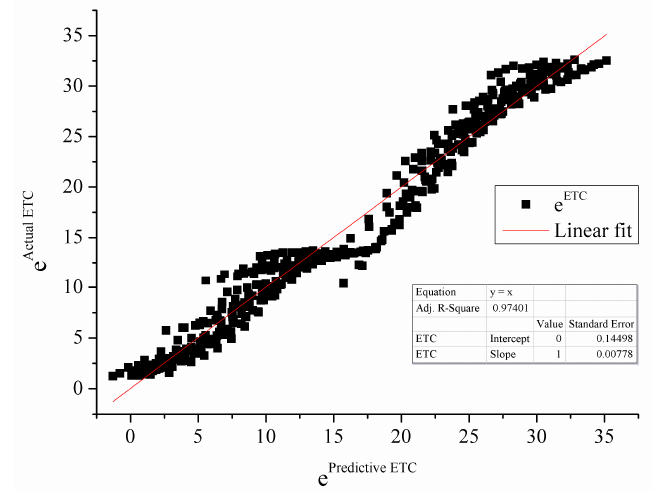
Figure 9. The fitting curve of the predictive ETC versus the actual